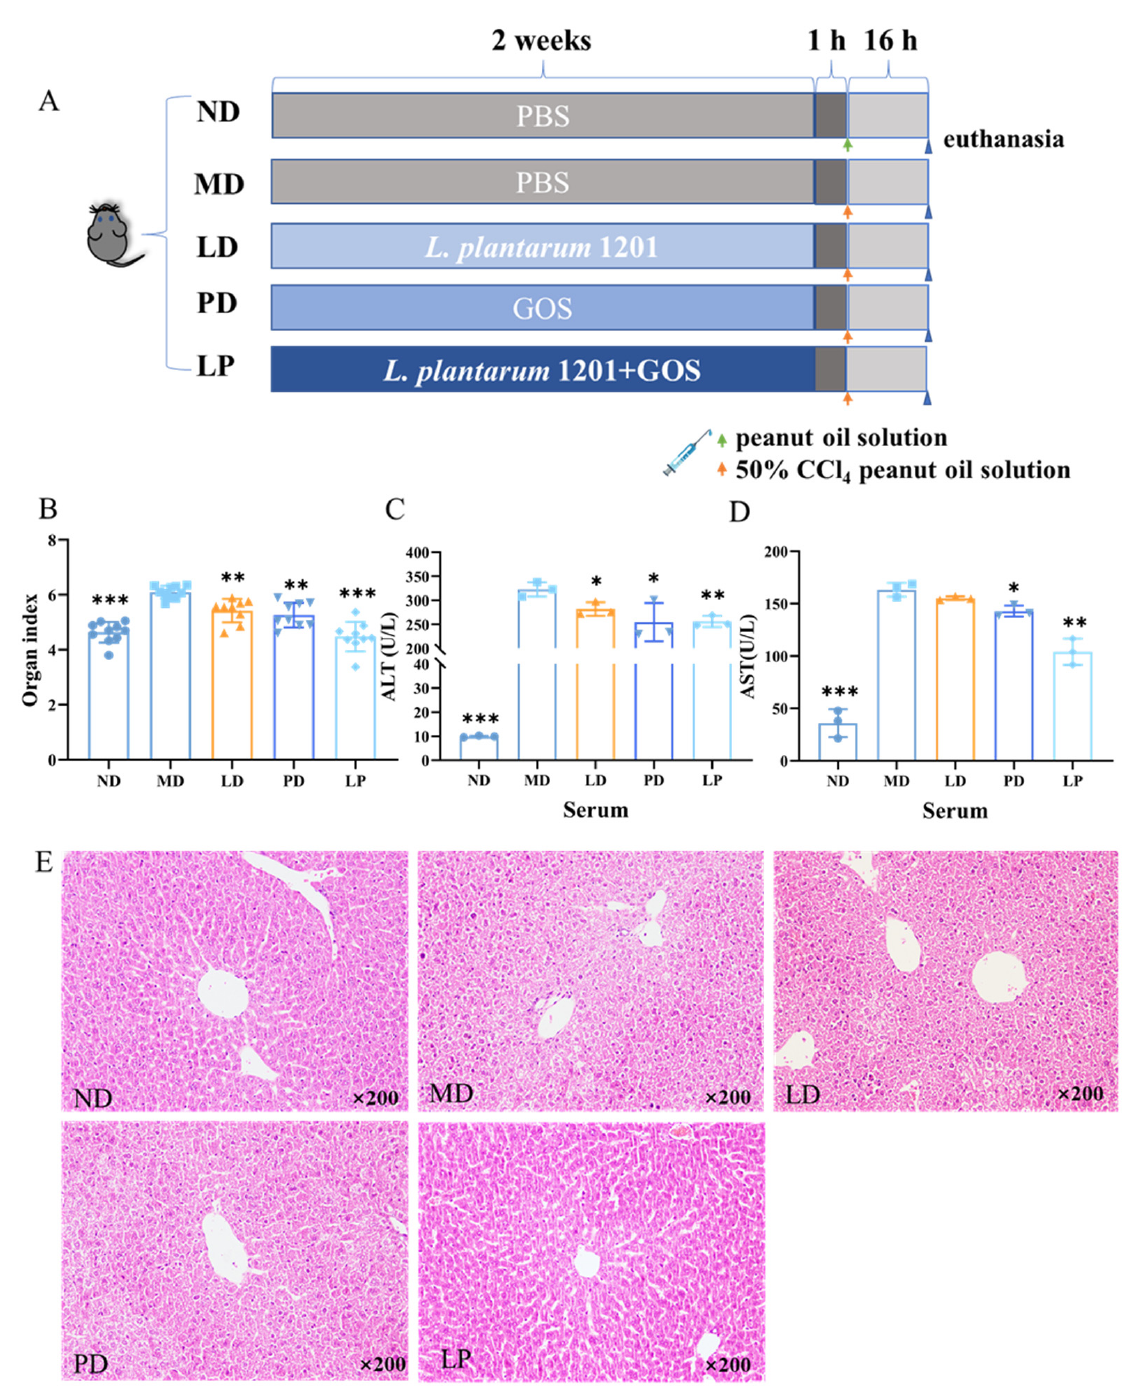
Figure 2. Synbiotics alleviated the dysfunction and pathological damage of the liver in CCl 4 -induced ALI mice. ( A ) Experimental set-up: C57BL/6N mice with an intraperitoneal injection of 2 μ L/g 50% CCl 4 peanut oil solution treated with probiotics, prebiotics, or synbiotics by daily gavage. ( B ) Liver index ( n = 9 mice/group; each data point represents one mouse). ( C , D ) ALT and AST enzyme activity in mouse serum ( n = 3). ( E ) H&E pathological section of mouse liver tissue ( n = 4). * p < 0.05; ** p < 0.01; *** p < 0.001; * is compared with MD; paired two-tailed t -test.